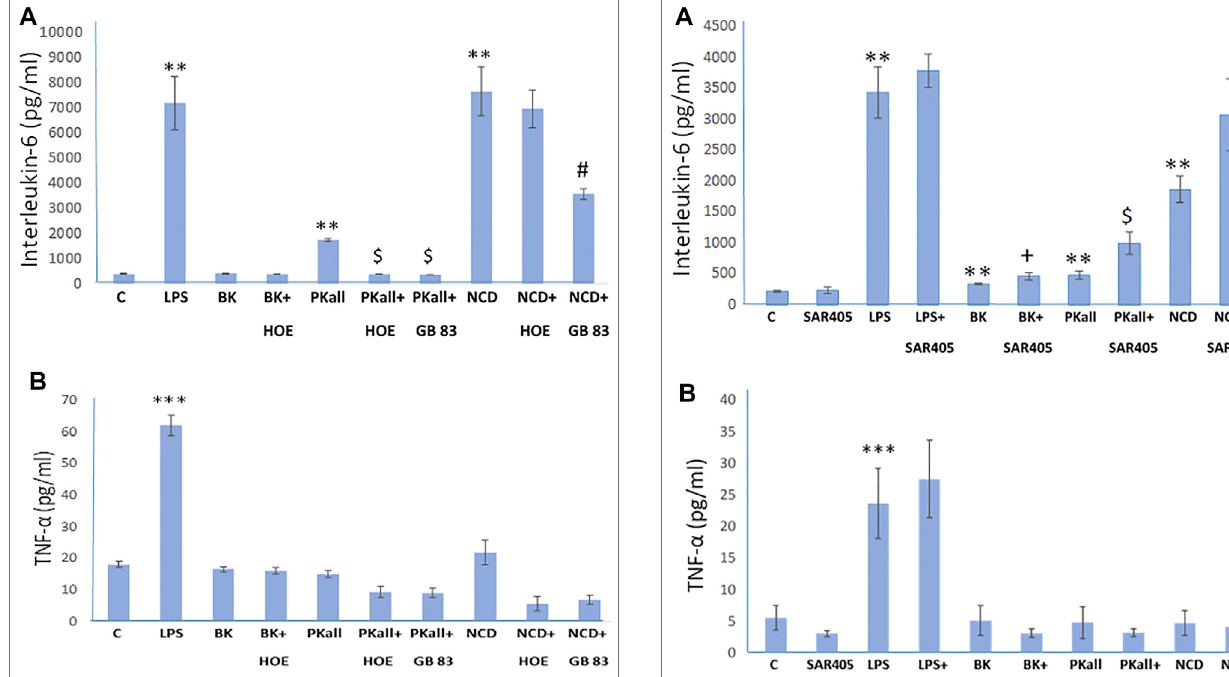
FIGURE 4 | Engagement of PAR 2 and B2KR in cytokine production in the microglial cell. Microglial cells were stimulated for 24 h with PKall (2.5 ng/ ml) or NCD (16.5 µg protein/ml) in the presence and absence of a B 2 KR antagonist HOE 140 (1 µM) and a PAR 2 antagonist GB 83 (2 μ M). Bar graphs depicts the levels of (A) interleukin-6 (IL-6, pg/ml), and (B) tumor necrosis factor-alpha (TNF- α , pg/ml) measured in the supernatant media by ELISA(** p ≤ 0.032,*** p ≤ 0.008 vs.C; $ p ≤ 0.008,PKallvs. PKall+ HOE 140, or PKall + GB 83; # p ≤ 0.025, NCD vs. NCD + GB 83, n (cid:1) 5).